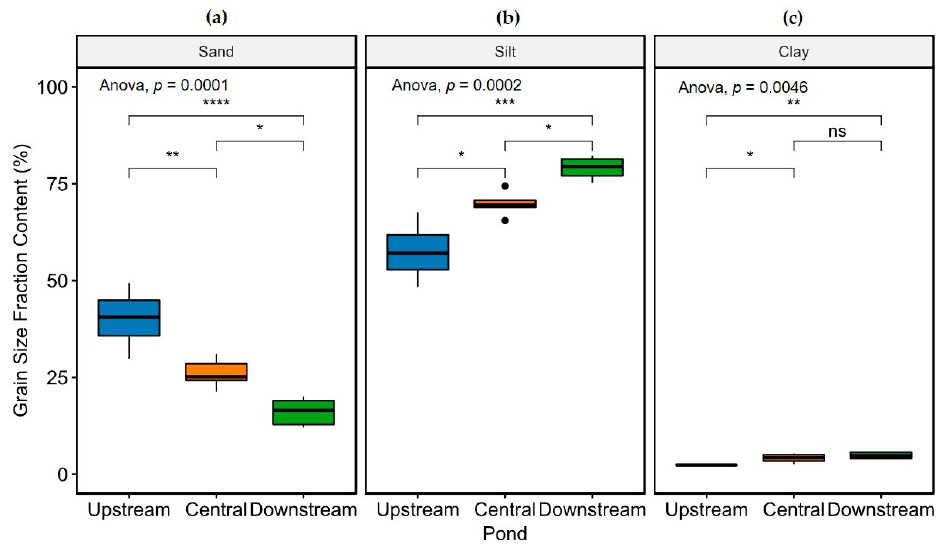
Figure 7. Boxplots showing the range of sediment grain size content (%) of ( a ) sand; ( b ) silt and ( c ) clay in each pond from trap deployment during March 2019 (Upstream Pond n = 4; Central Pond n = 5; Downstream Pond n = 5). Median values are represented by bold lines and significance levels for Tukey’s tests by **** ( p < 0.0001), *** ( p < 0.001), ** ( p < 0.01), * ( p < 0.05), ns ( p > 0.05).